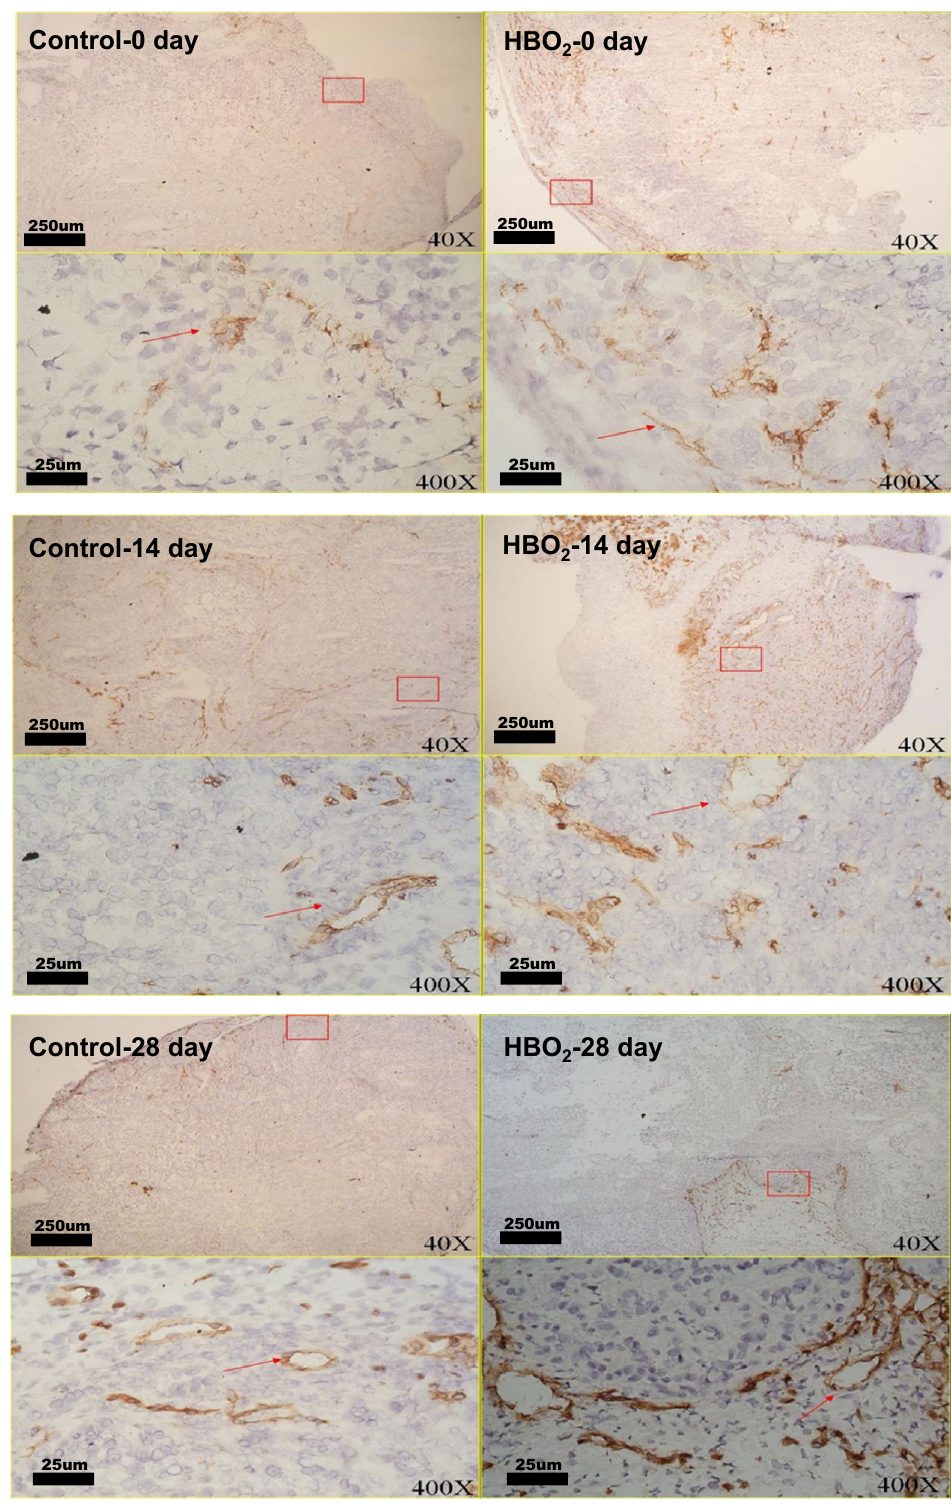
Figure 4. Comparative analysis of immunohistochemical CD31 antigen expressions from groups of mice. Significantly increase of CD31 was observed after 14 days and 28 days of HBOT